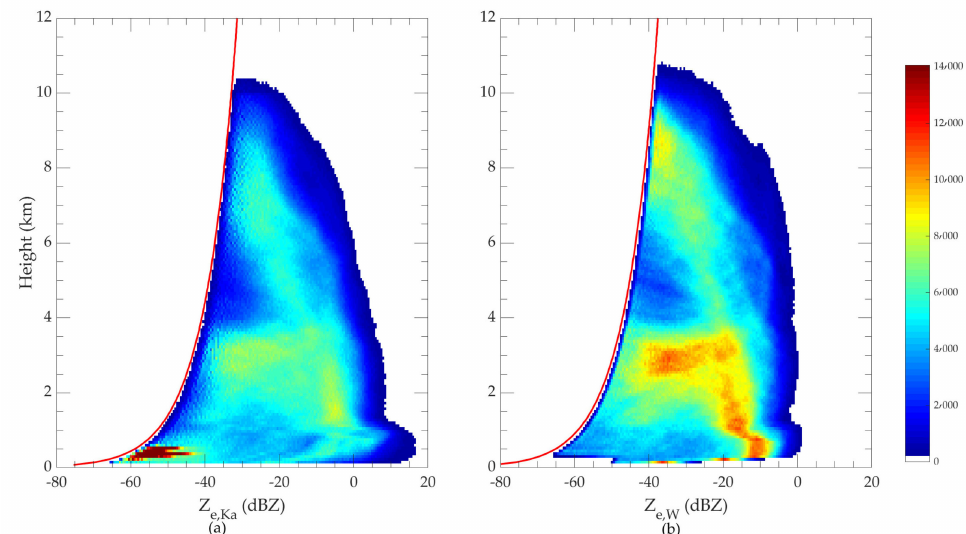
Figure 2. The sensitivity calculated (red line) vs. the statistical number of the measured reflectivity by the ( a ) Ka-band radar and ( b ) W-band radar of the DDCR. The color indicates the count of cloud bins calculated every 30 m height and 0.5-dBZ